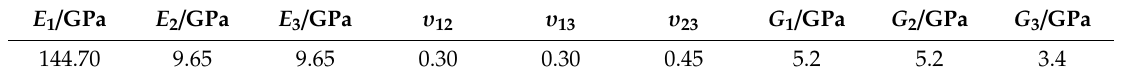
Table 1. Properties of the composite material used.